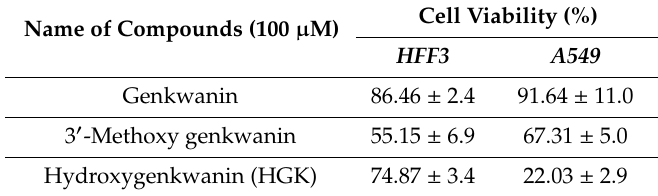
Table 1. Cytotoxic effects of the compounds Genkwanin, 3′ -Methoxy genkwanin, and hydroxygenkwanin (HGK).